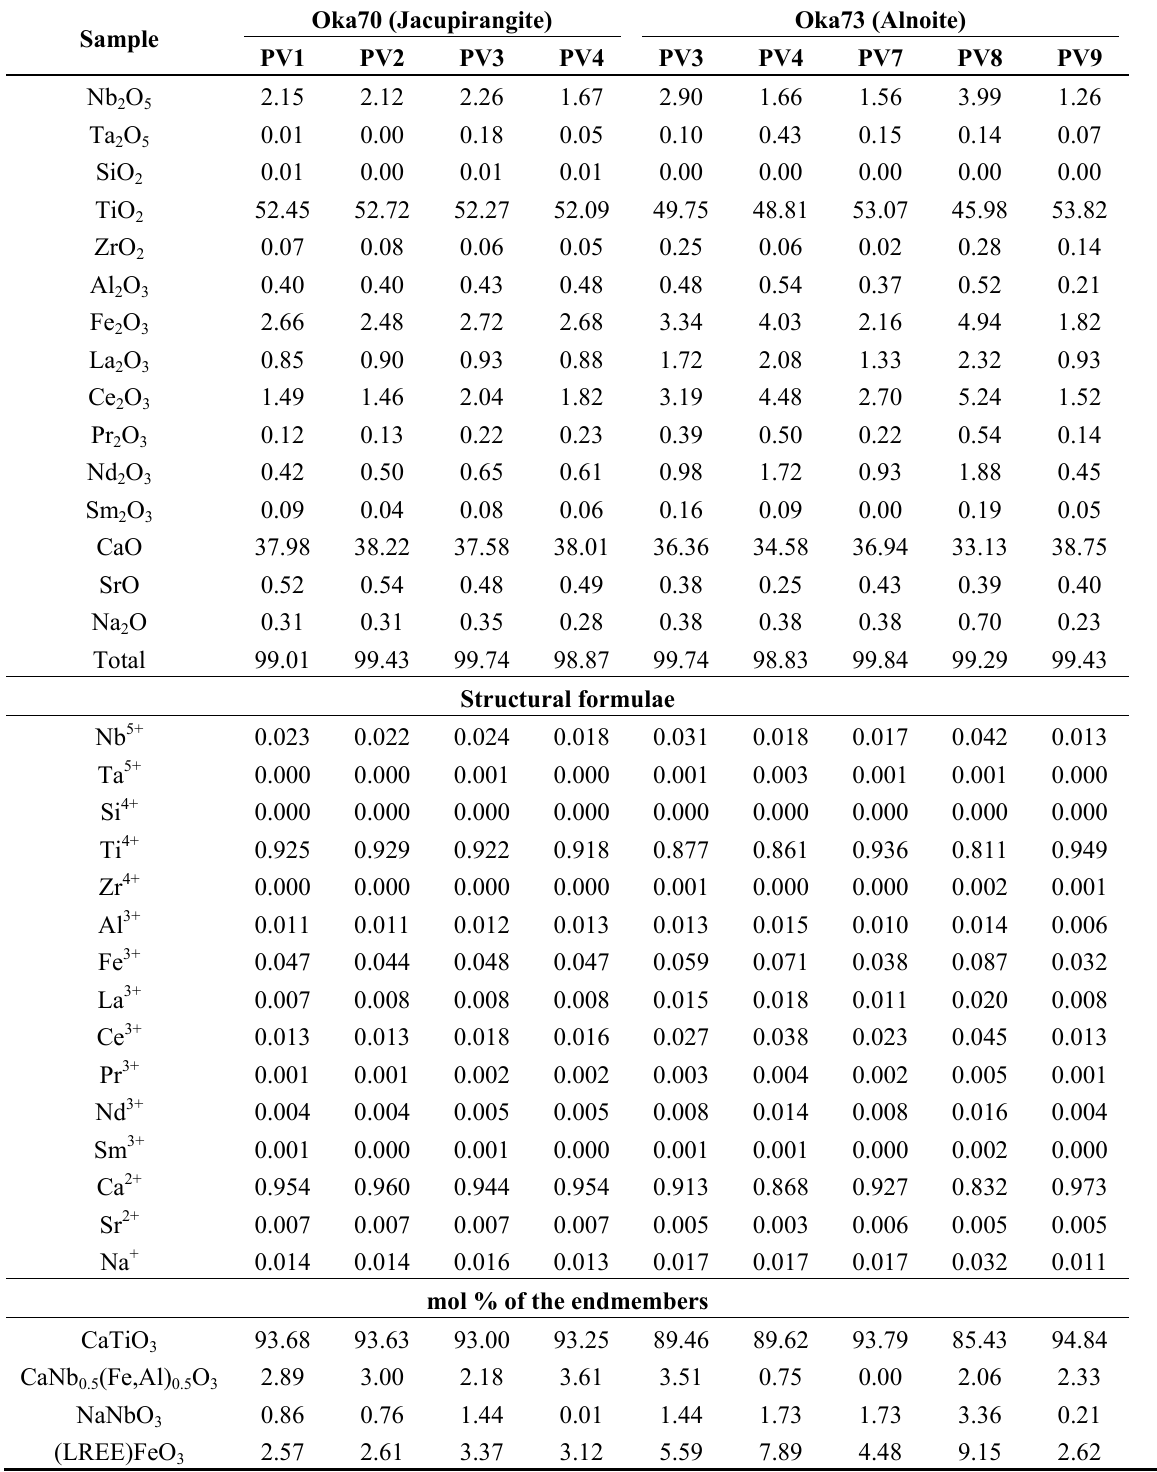
Table 2. Major element compositions of perovskite from the Oka complex.